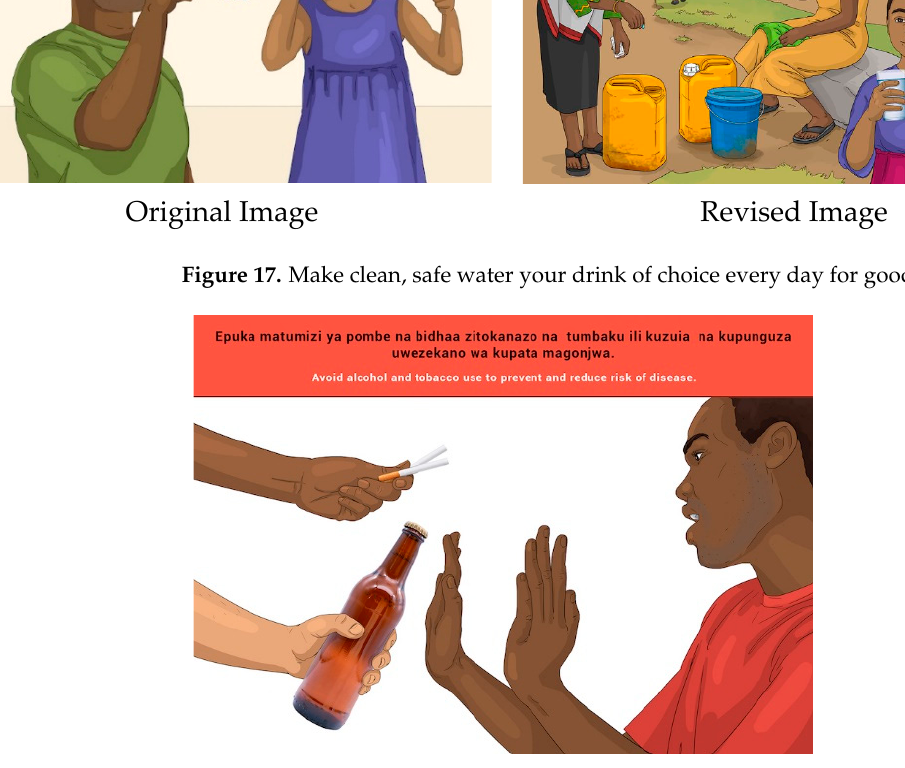
Figure 18. Avoid drinking alcohol and tobacco use to prevent and reduce risk of diseases. Participants articulated the meaning of both the message and the image very well. They commented that the image complemented the message well. A concern was raised that the government allows the trade in alcohol and cigarettes, hinting that the govern- ment and the proposed FBDG message are saying the opposite, which are two conflict- ing policy positions of government (health and trade policy). Participants proposed there should be a person affected by the consumption of al- cohol and cigarettes depicted in the image. The researchers discussed this suggestion and felt that the image should support the word “avoid” and should reflect a positive action of saying “no” to these products. No further changes were therefore made to the image.